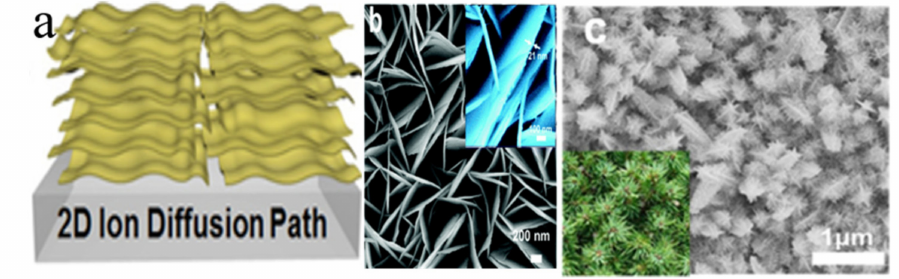
Figure 8. Different high-dimensional tungsten oxide nanostructures: ( a ) stacked nanosheet [98], ( b ) nanoarray [99], ( c ) three-dimensional [100].